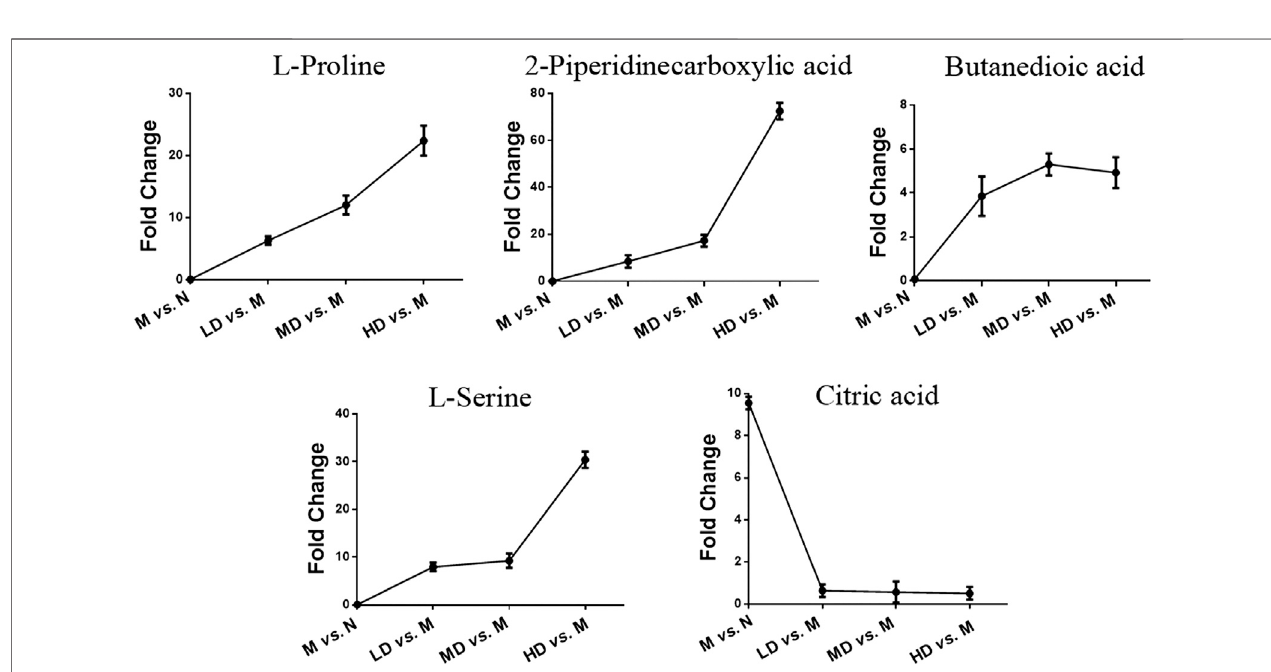
FIGURE 7 | Selected differential metabolic markers. The common differential metabolites present in three of CQR-treated groups were selected as potential metabolic biomarkers.